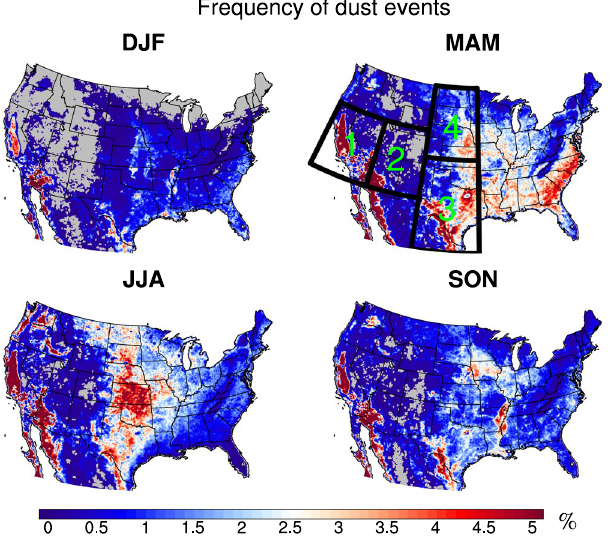
Figure 1. Climatology (2003–2015) of the frequency of dust events. Black boxes denote the averaging areas: Box 1 for the southwestern U.S. (WST1; 32°–42°N, 114°–124°W), Boxes 1 and 2 for the western U.S. (WST; 32°–42°N, 105°–124°W), Box 3 for the southern Great Plains (SGP; 25°–38°N, 95°–105°W), and Box 4 for the northern Great Plains (NGP; 38°–49°N, 95°–105°W). Missing values are shaded in grey. Maps were generated using the National Center for Atmospheric Research (NCAR) Command Language (NCL; https://www.ncl. ucar.edu/), version